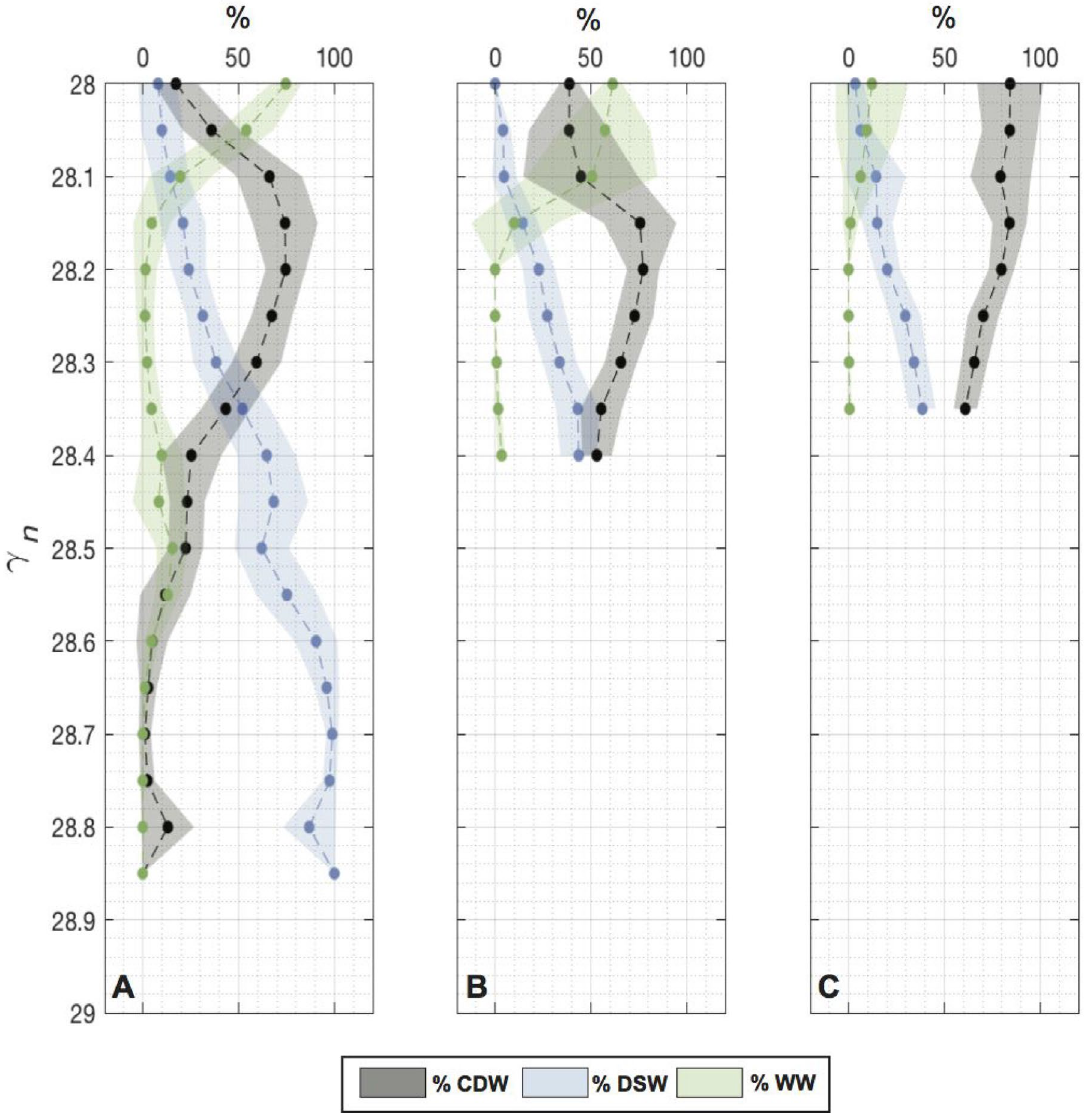
Figure 4. Mean percentage contributions of “source” water-masses (green: WW, blue: DSW and black: CDW) in the Weddell gyre along ( A ) the continental slope (green stations in Fig. 1B), ( B ) the gyre side of the A23 segments (gray stations in Fig. 1B) and ( C ) the Scotia Sea side of the A23 segment (orange stations in Fig. 1B). The mean percentage contributions are computed in 0.025 γ n bins. Shading indicates standard deviations around the mean of each γ n bins. Standard deviation ranges include negative and above 100% water-masses fraction, these are however not physically plausible